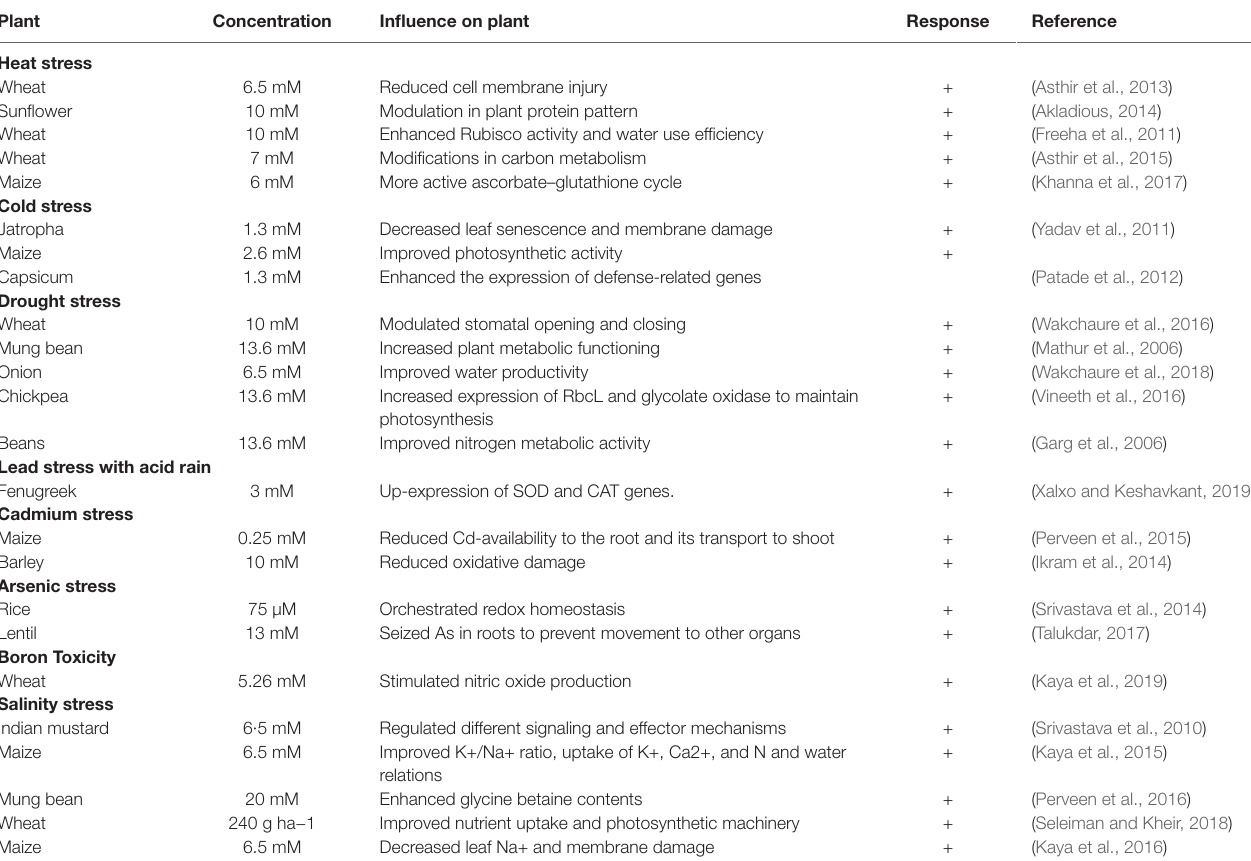
TABLe 1 | Influence of TU application on tolerance against abiotic stresses in crop plants.